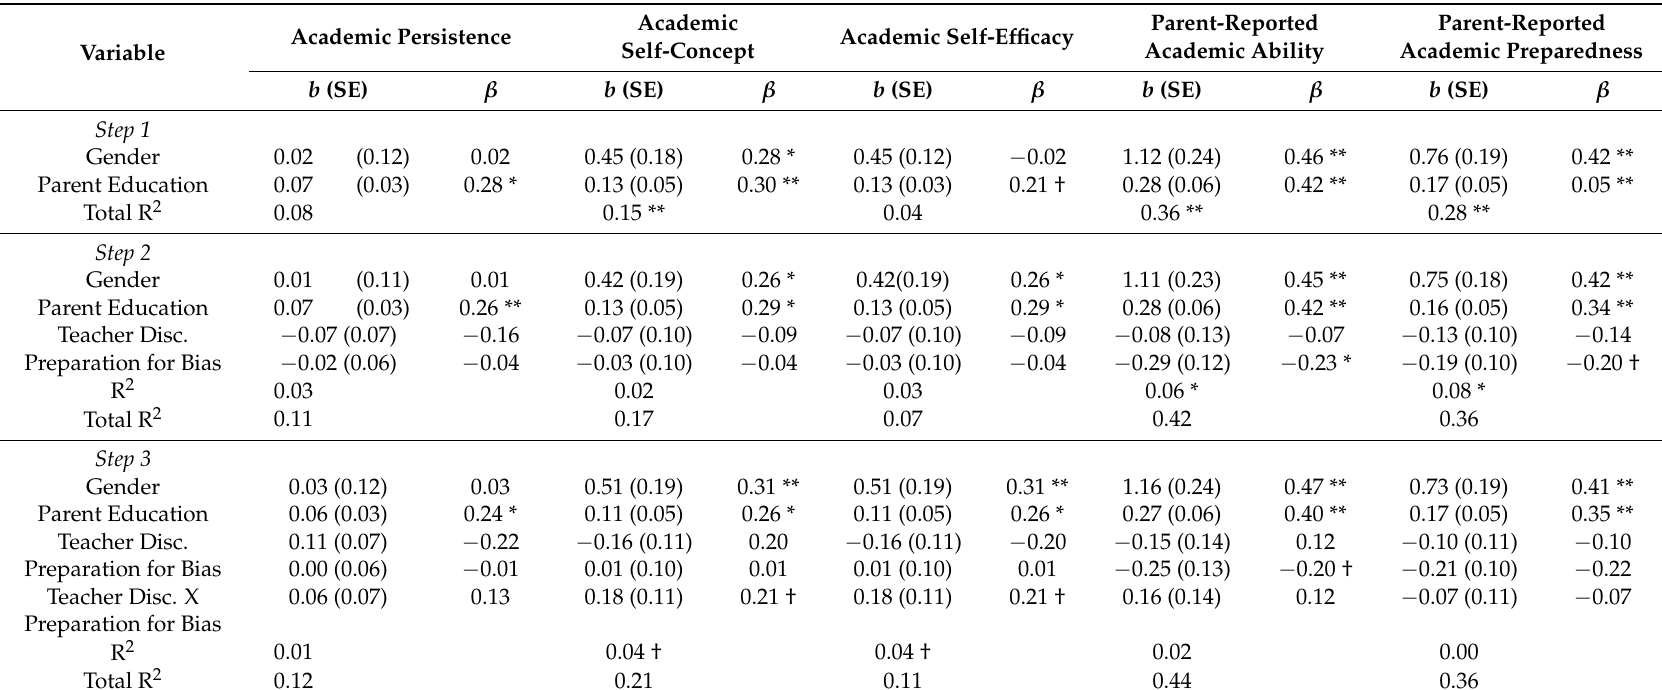
Table 4. Perceived Teacher Discrimination by Preparation for Bias: Academic